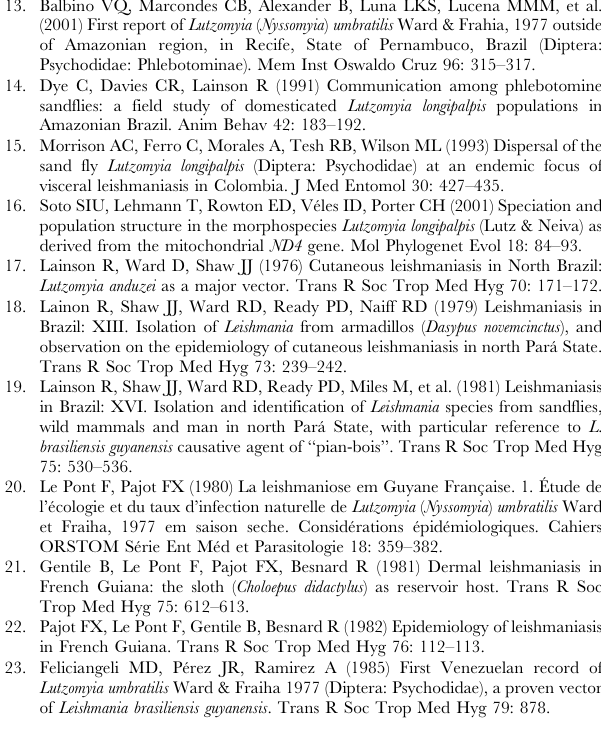
Table S1 Variable sites of haplotypes of Lutzomyia umbratilis and Lutzomyia anduzei . H, haplotypes; H1 to H52, haplotypes of Lutzomyia umbratilis ; H53 to H58, haplotypes of Lutzomyia anduzei . The dots indicate identical nucleotides with the H1. The frequency of each haplotype is provided in Table